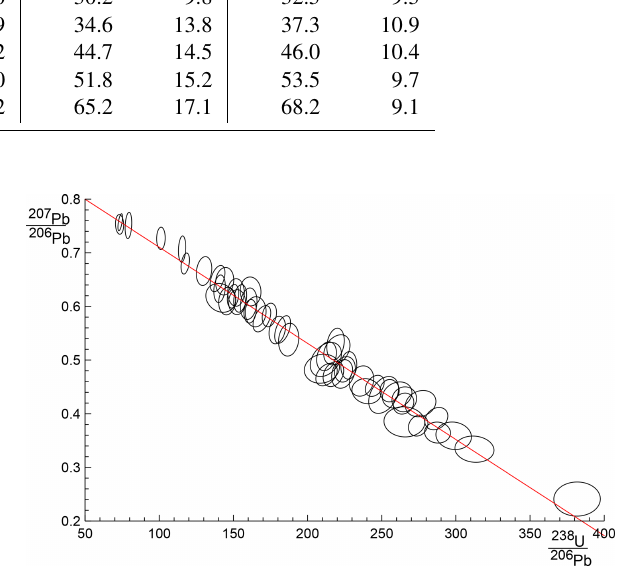
Figure 7. Laser ablation example 0708. See